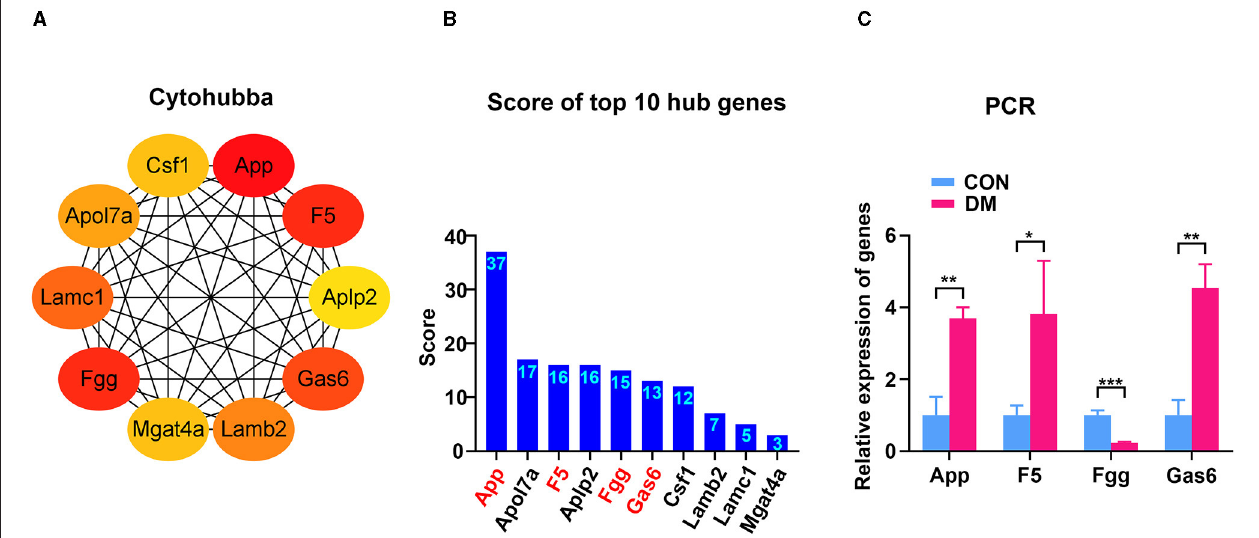
FIGURE 6 | Identification and confirmation of the hub genes. (A) Ten hub genes were identified by cytoHubba. Four hub genes (App, F5, Fgg, and Gas6) were detected by both MCODE and cytoHubba. (B) The concrete scores of the hub genes. (C) Relative expression of the four hub genes above by PCR. N = 3/group. * P < 0.05, ** P < 0.01, *** P < 0.001. MCODE, molecular complex detection; PCR, polymerase chain